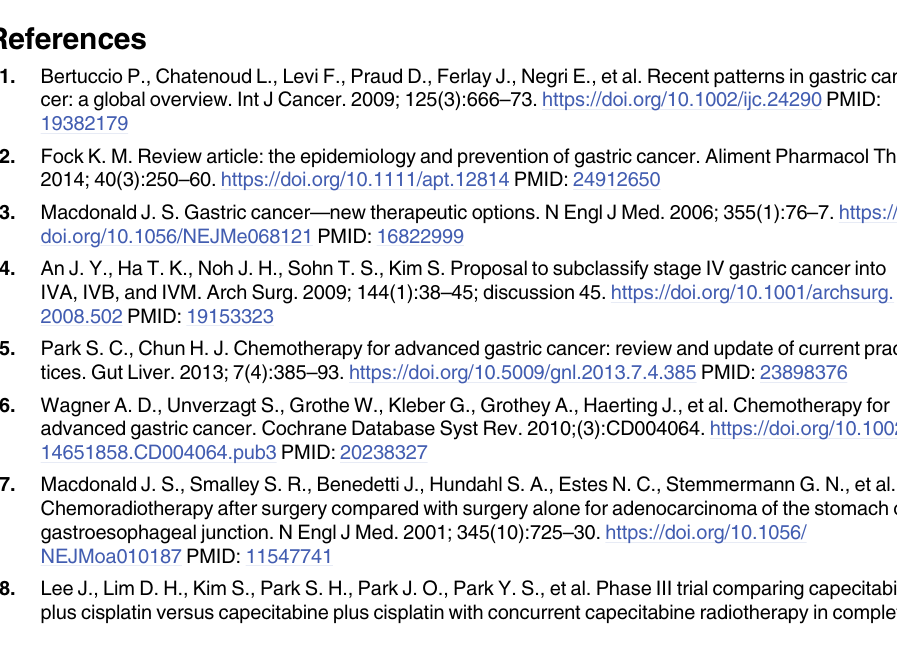
S1 Fig. Trend of the proportion of patients with advanced gastric cancer from 2004 to 2013. (TIF) S2 Fig. Treatment patterns for patients with advanced gastric cancer from 2004 to 2013 according to treatment modality. RT: radiation.